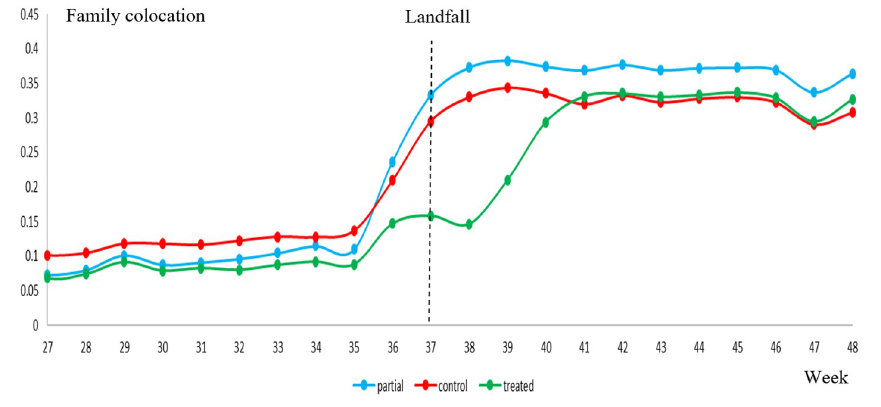
Fig 1. Family colocation over